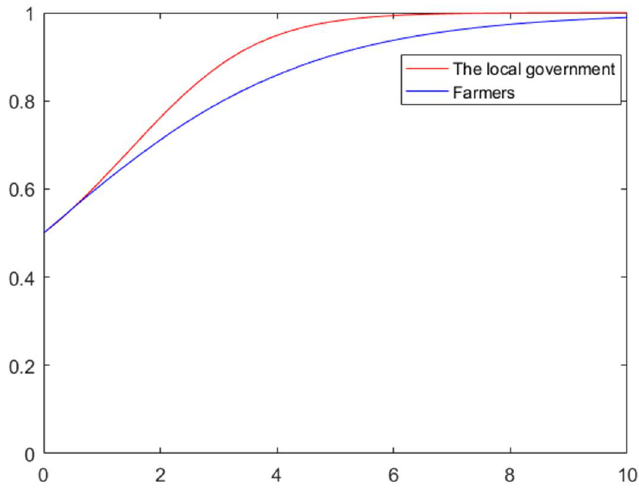
Figure 9. Simulation results at the third stage ( ∆ S 2 = 1.5, ∆ S 1 = 3.5, I 2 = 3).